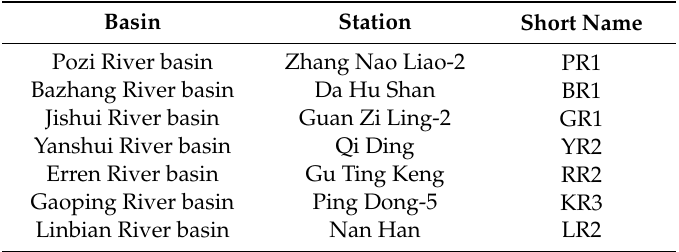
Table 1. Information on rainfall stations at each